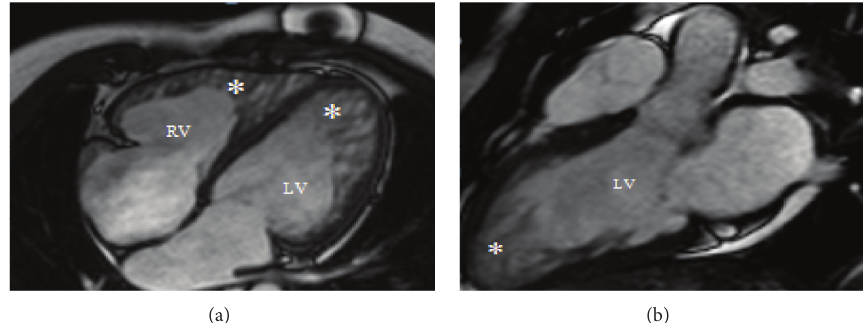
Figure 2: Cardiac MRI of the heart. (a) Cardiac MRI showing extensive biventricular trabeculations with (b) sagittal view demonstrating deep recesses in the left ventricle cavity (see